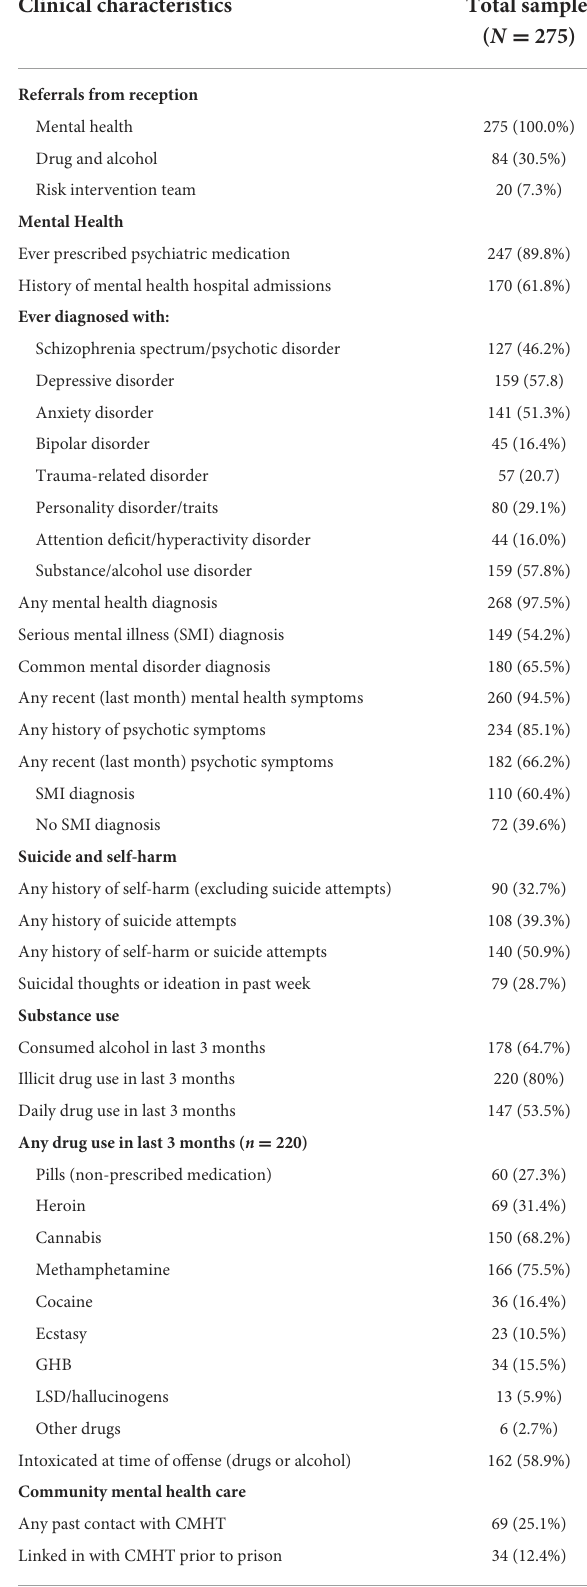
TABLE 2 Clinical characteristics of the interviewed sample at